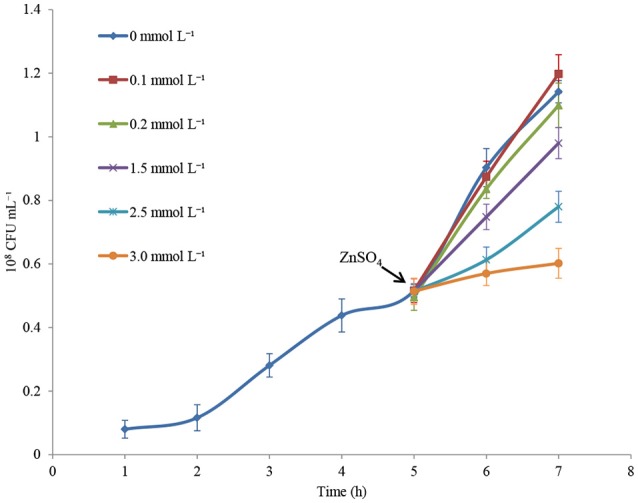
Growth curves of P. putida KT2440 cultured in CDM medium or in CDM medium supplemented with zinc. Addition of zinc is indicated by arrow. The values are means for triplicate cultures. The error bars indicate standard deviations.